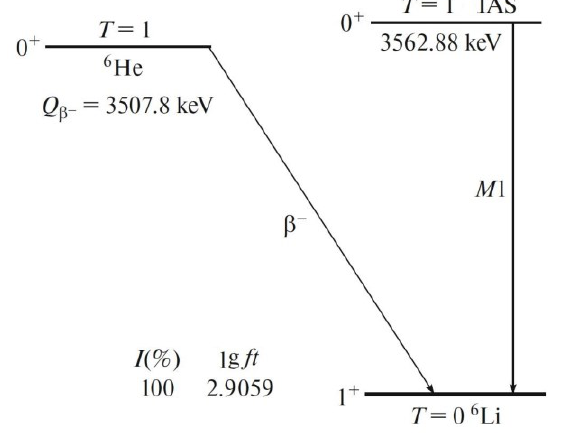
Fig. 1. 6 He β-decay and M 1 γ-decay of corresponding IAS.